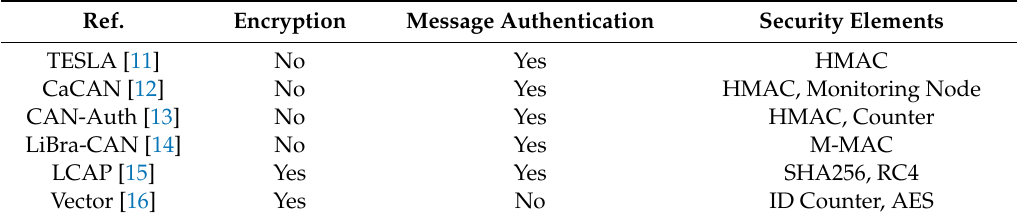
Table 2. Comparison of controller area network (CAN) message protection schemes.